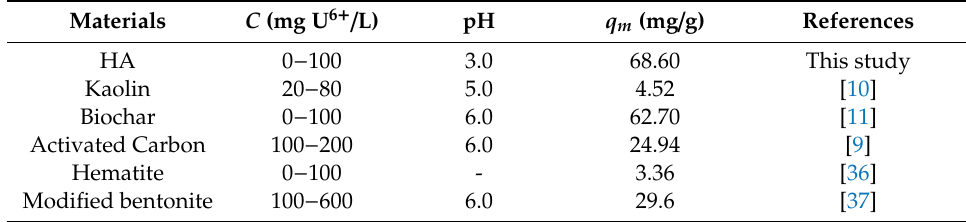
Table 5. The comparison between this study and previous